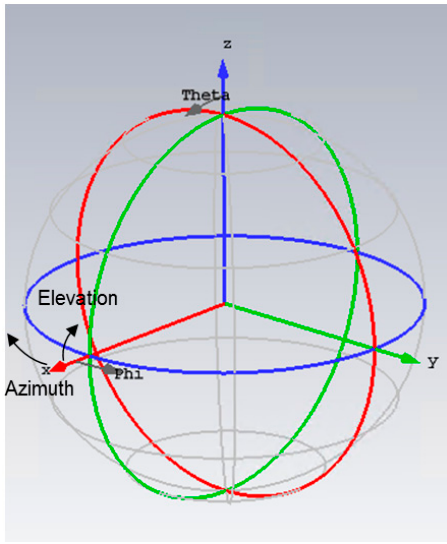
Figure 16. Coordinate Systems for both the GNSS results (elevation and azimuth) and e.m. simulations (phi and theta).